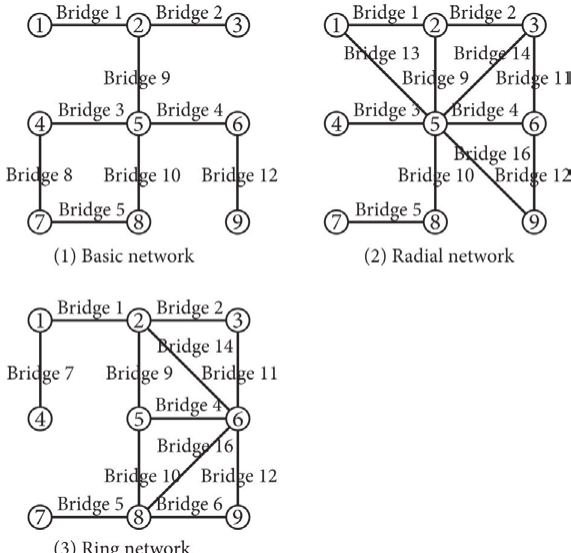
Fig. 6. Bridge decommission example (a case that is within the budget, where the demographic energy ( A k ) is maximum, Scenario